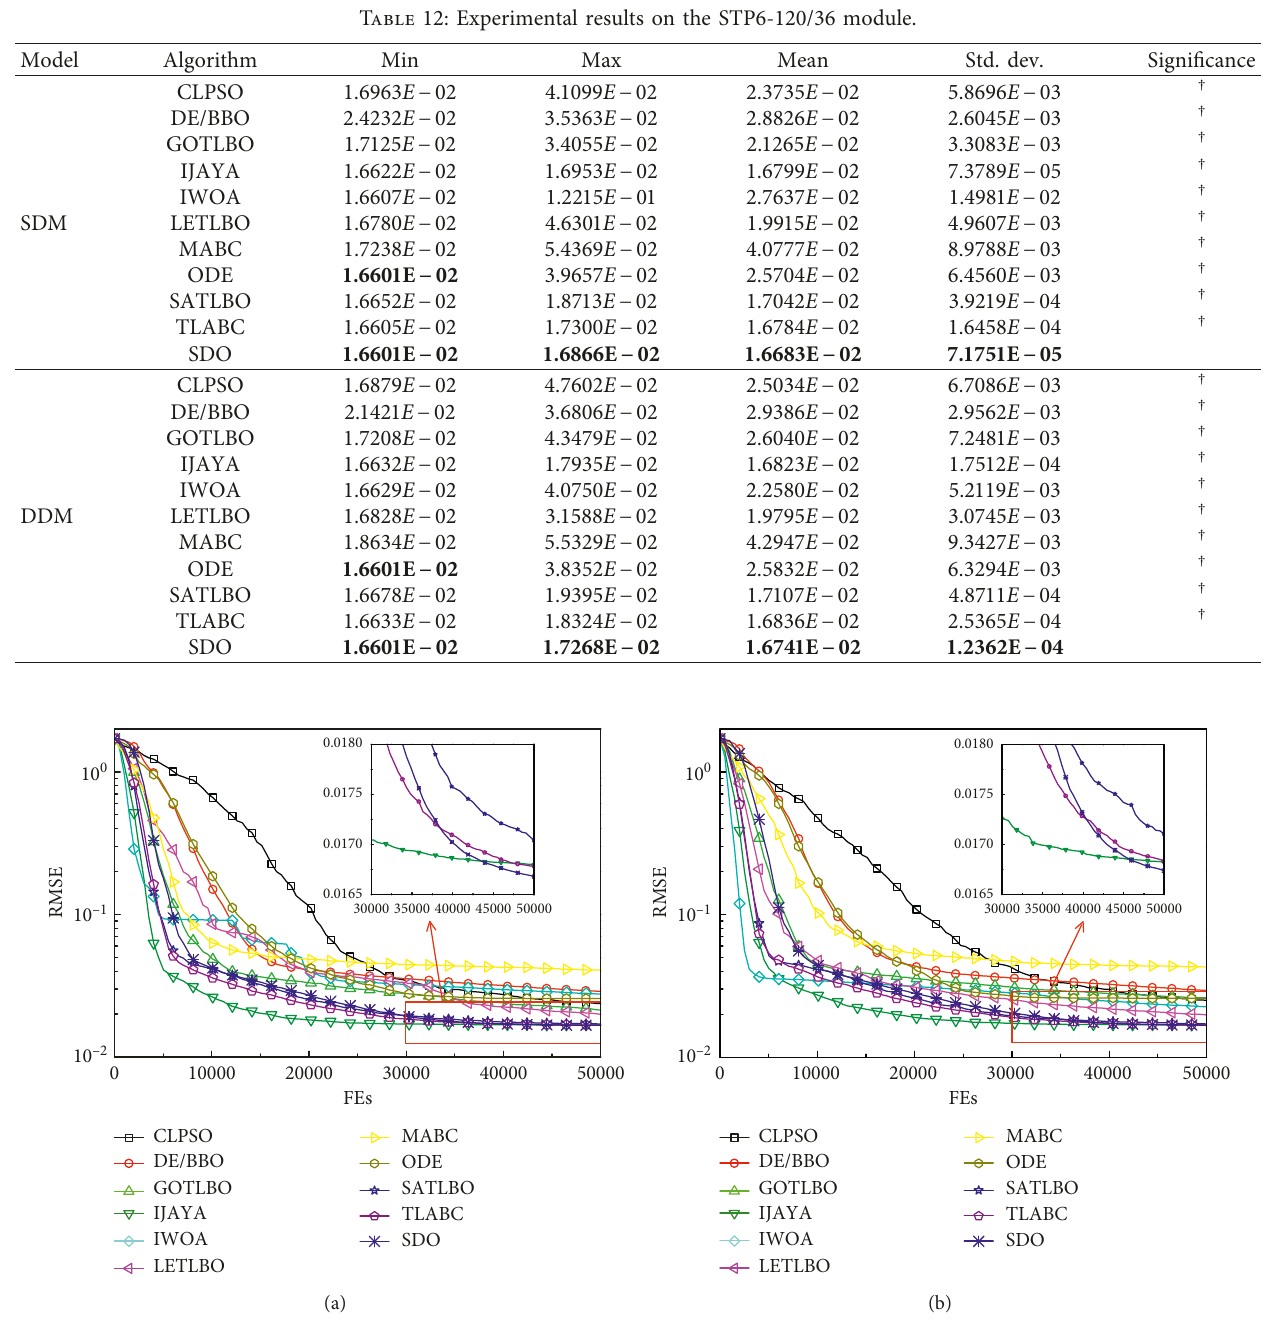
Figure 11: Convergence curves for the STP6-120/36 polycrystalline module. (a) SDM; (b) DDM. Table 13: Extracted value for the parameters of STP6-120/36 module by